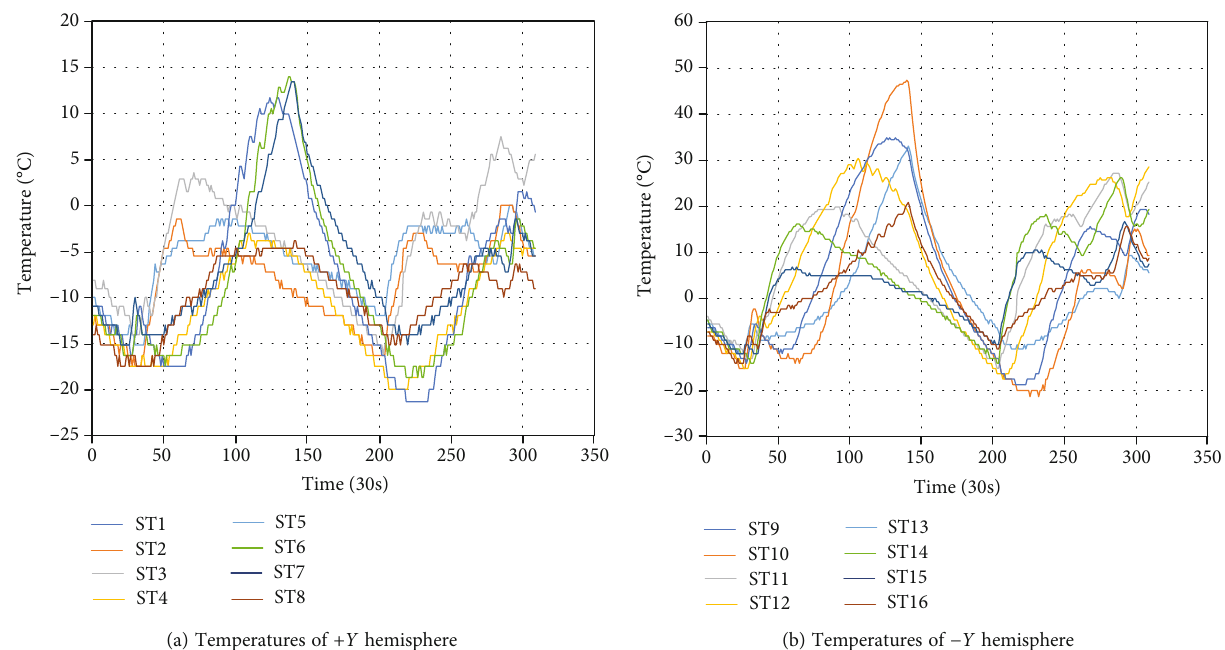
Figure 16: Temperatures of hemispheres on orbit on 2021.6.03 ( X : time (30 s); Y : temperature ( ° C); ST N : surface temperature of N # panel in Figure 14).